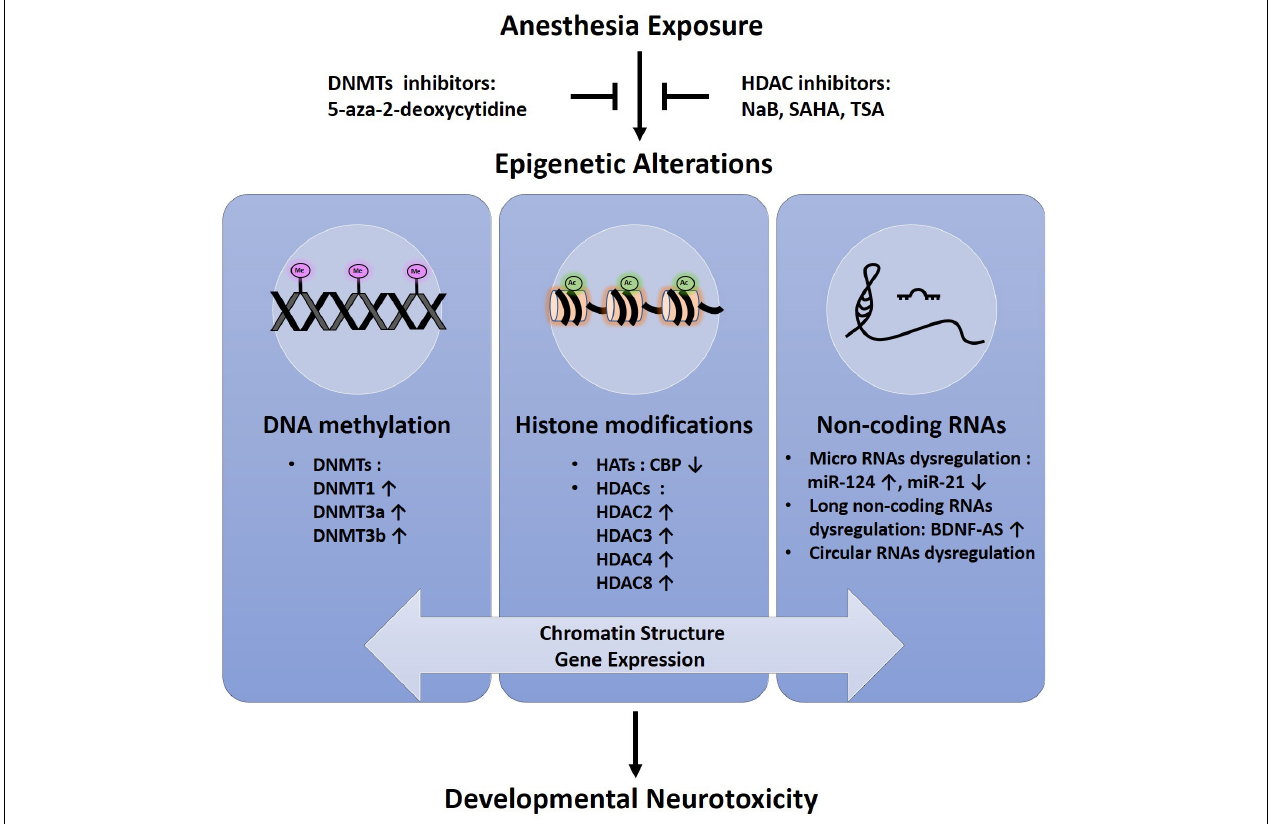
FIGURE 1 | Schematic representation of epigenetic alterations in anesthesia-induced neurotoxicity in the developing brain.